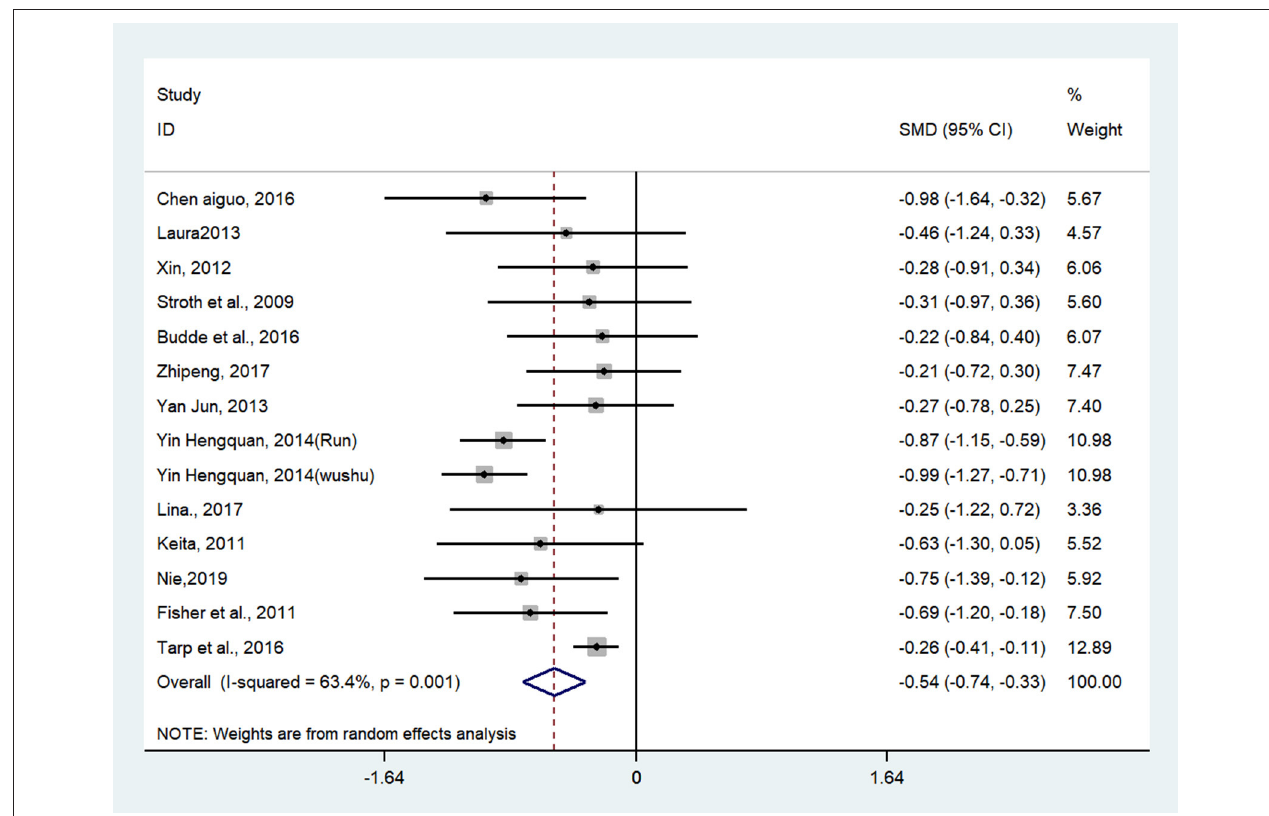
FIGURE 5 | The effect of chronic exercises on working memory (SMD = standardized mean difference; CI = confidence interval).